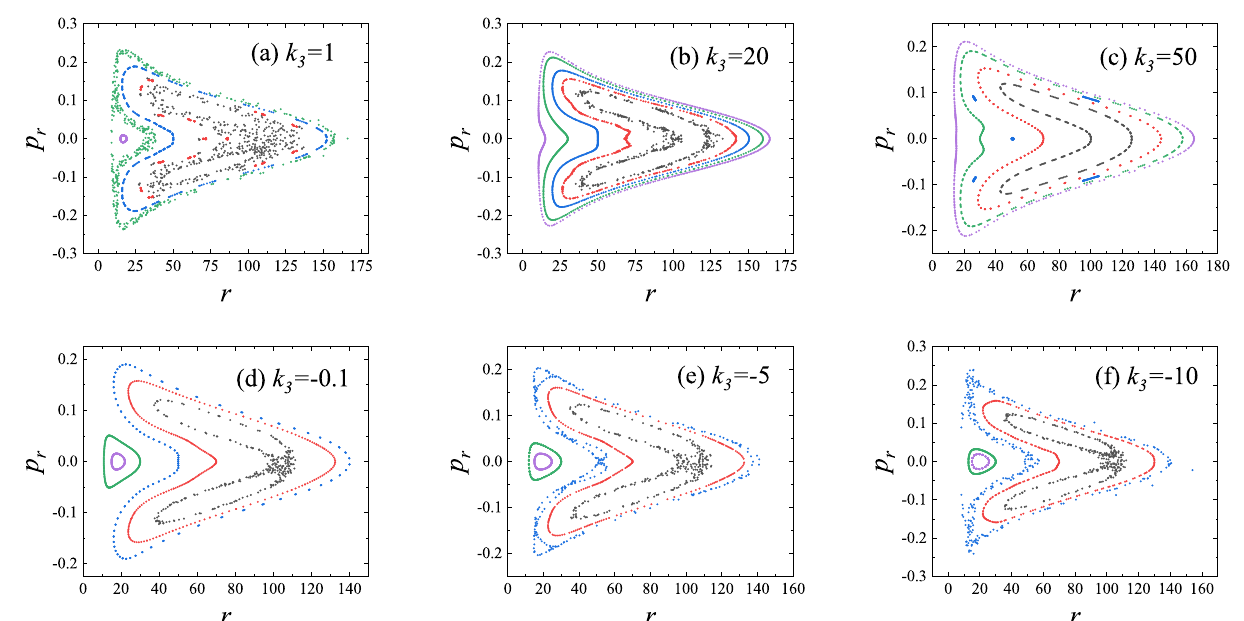
Figure 13. Similar to Figure 11, but k 2 in Figure 11 is replaced with k 3 and energies E are different. Here, k 2 = 0.5. ( a – c ): E = 0.995 and k 3 > 0. ( d – f ): E = 0.9945 and k 3 < 0.